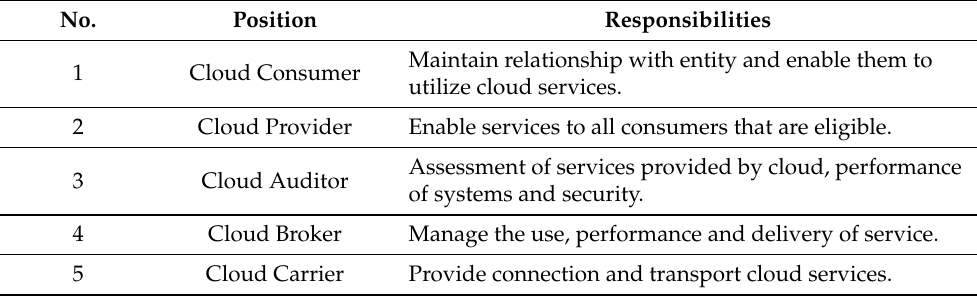
Table 3. Responsibilities of different positions associated with cloud services. No. Position Responsibilities Maintain relationship with entity and enable them to 1 Cloud Consumer utilize cloud services. 2 Cloud Provider Enable services to all consumers that are eligible. Assessment of services provided by cloud, performance 3 Cloud Auditor of systems and security. 4 Cloud Broker Manage the use, performance and delivery of service. 5 Cloud Carrier Provide connection and transport cloud